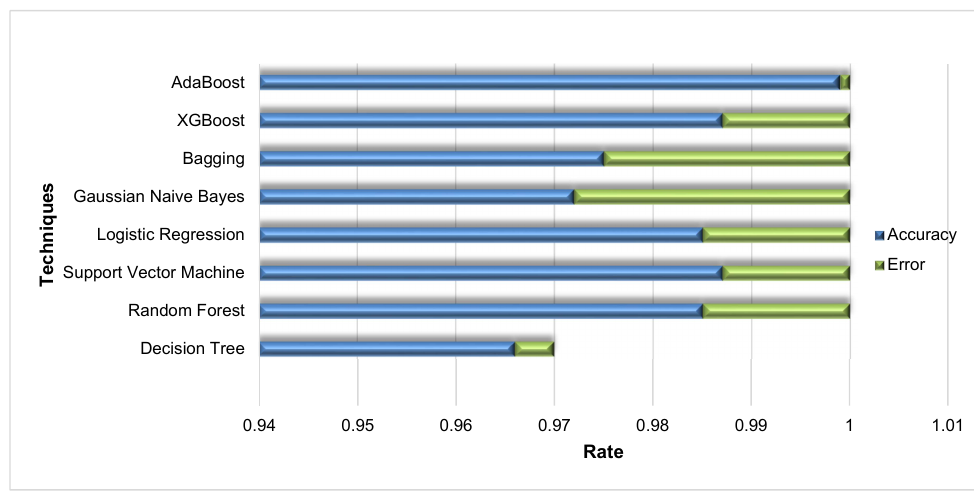
Figure 18. Classifier comparison based on